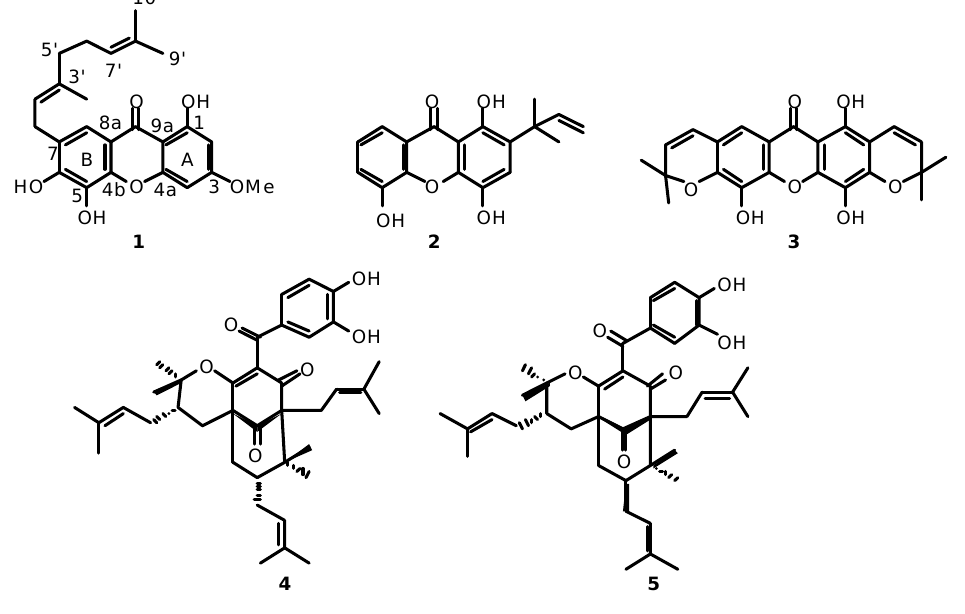
Figure 1. Structures of compounds 1 - 5